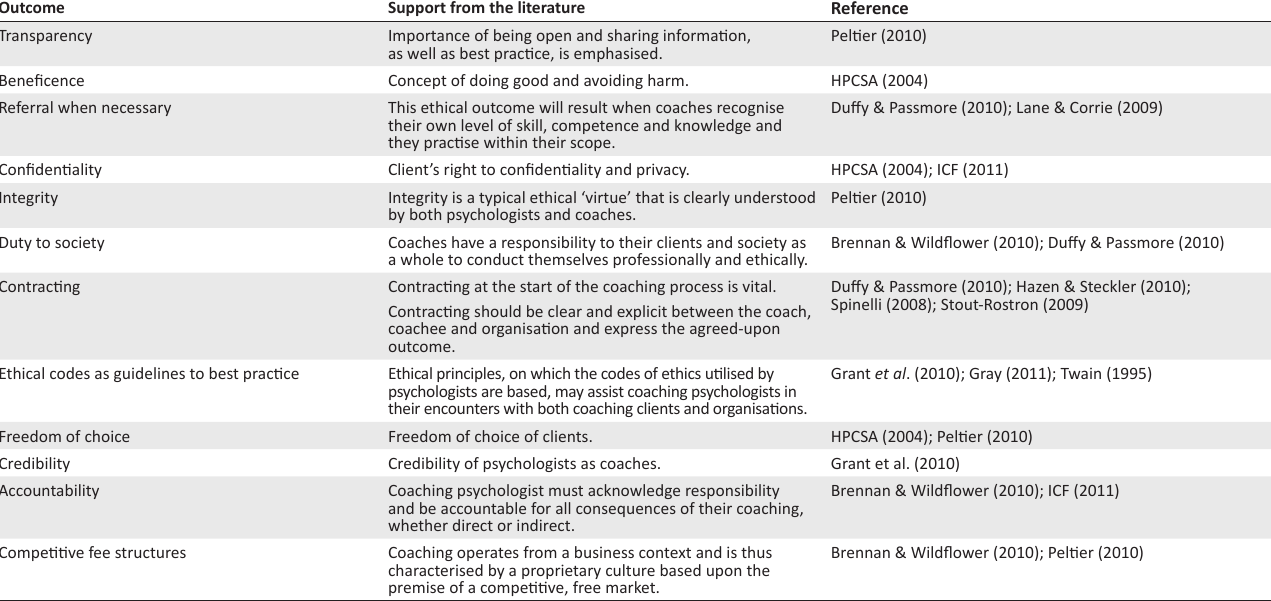
TABLE 5: Ethics outcomes as identified and supported by the South African coaching psychologists.